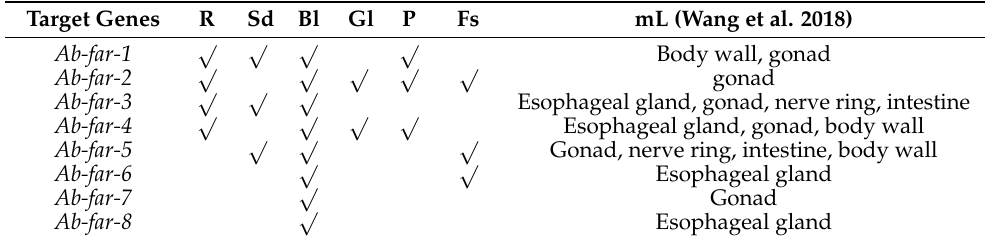
Table 4. Phenotypic changes after silencing Ab-far-n of Aphelenchoides besseyi . Target